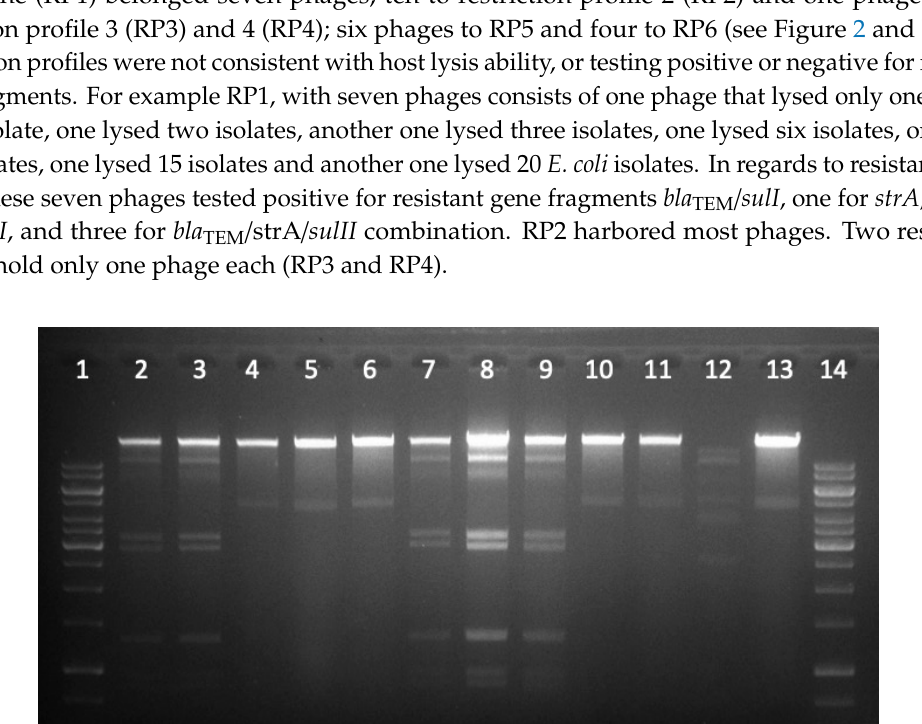
Figure 1. Ability of phages to lyse none, one, or more E. coli ( y -axis) ( a ) and susceptibility of the E. coli isolates to be lysed by none, one, or more of the 60 phages ( y -axis) ( b ).